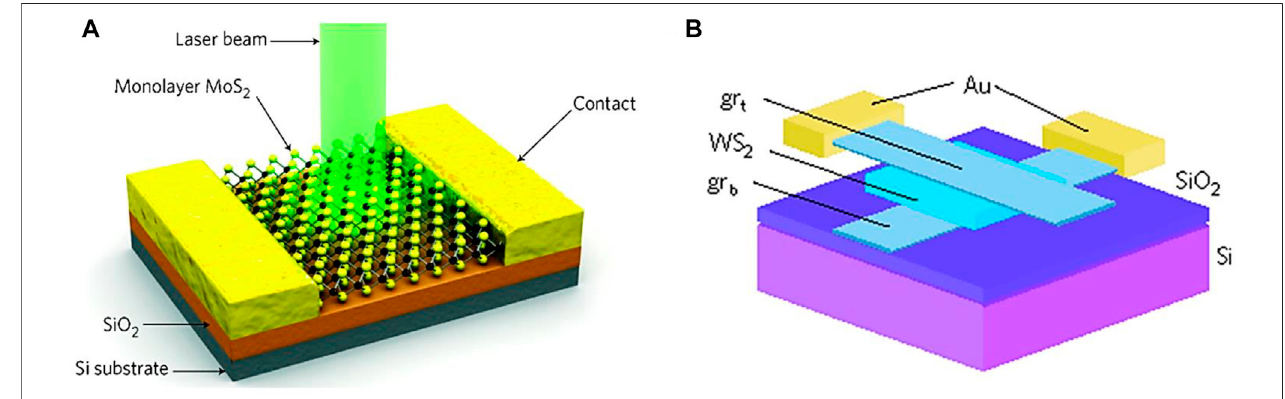
FIGURE9 |(A) Schematic ofMoS 2 based photodetectors (Lopez-Sanchez et al., 2013),and (B) Schematic of WS 2 based photodetectors (Koppens et al., 2014); Reproduced with permission from (Lopez-Sanchez et al., 2013; Koppens et al., 2014).